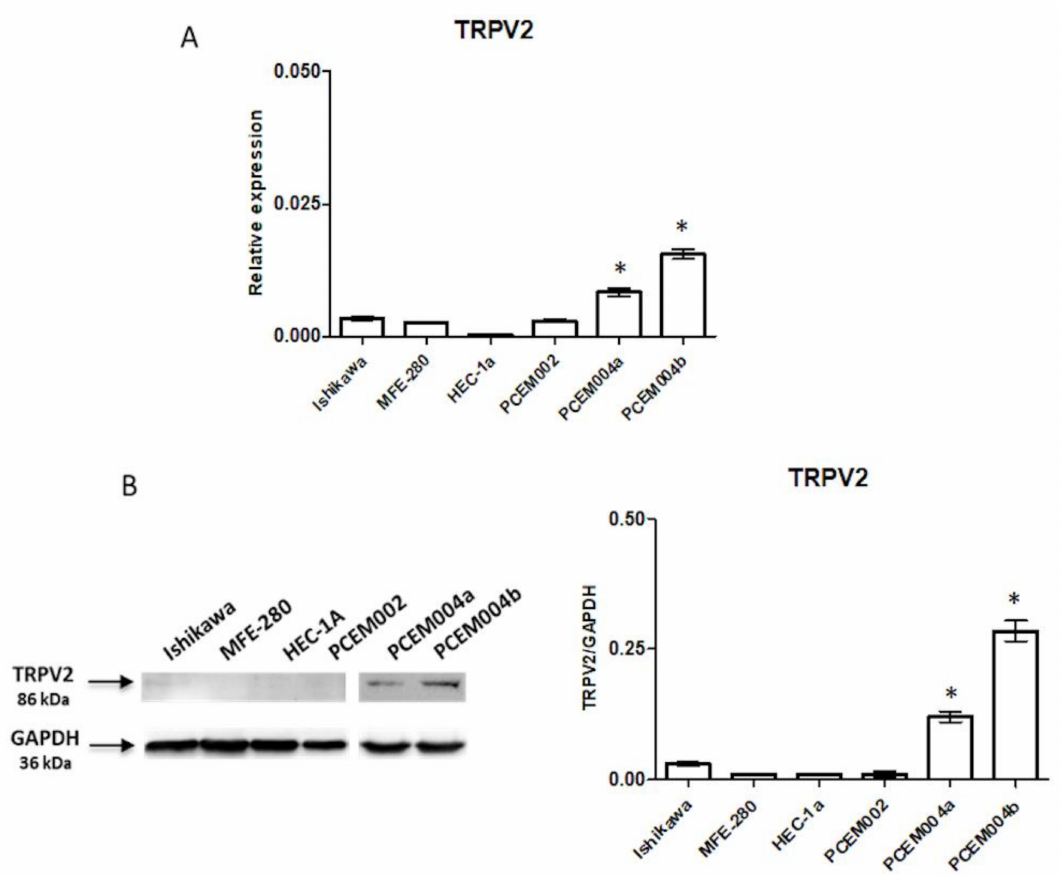
Figure 2. TRPV2 expression on EC cell lines. ( A ) TRPV2 mRNA expression was evaluated by quantitative real time-PCR (qRT-PCR) in six EC cell lines. TRPV2 mRNA levels were normalized for glyceraldehyde-3-phosphate dehydrogenase ( GAPDH) expression. Data are expressed as fold mean ± standard deviation (SD) of three separate experiments. * p < 0.05 vs. type I EC cell lines ( B ) TRPV2 protein expression was evaluated by Western blot in six EC cell lines. TRPV2 densitometry values were normalized to GAPDH used as loading control. Densitometric values shown are the mean ± SD of three separate experiments. * p < 0.05 vs. type I EC cell